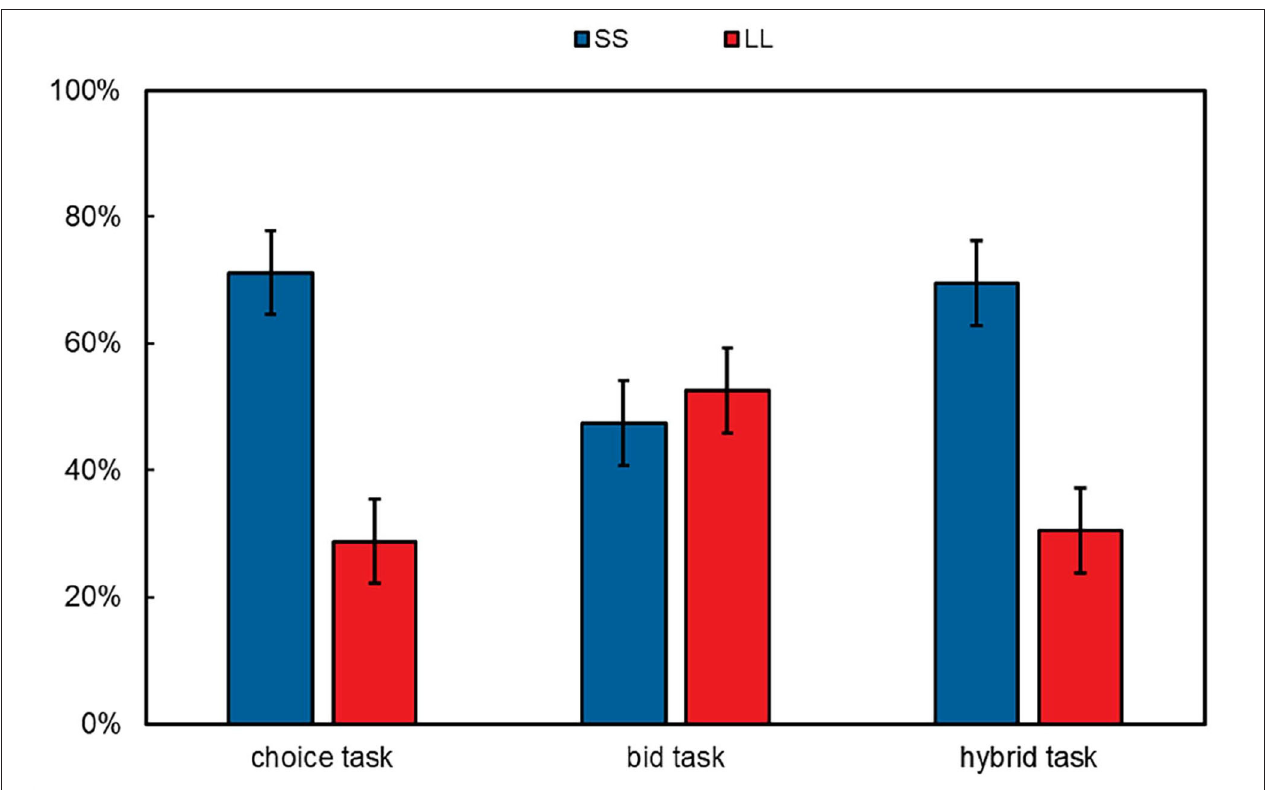
FIGURE 2 | Proportions of choosing the SS options/bidding higher for the SS options (SS) and choosing the LL options/bidding higher for the LL options (LL) in the choice, bid, and hybrid tasks. Error bars represent 95%